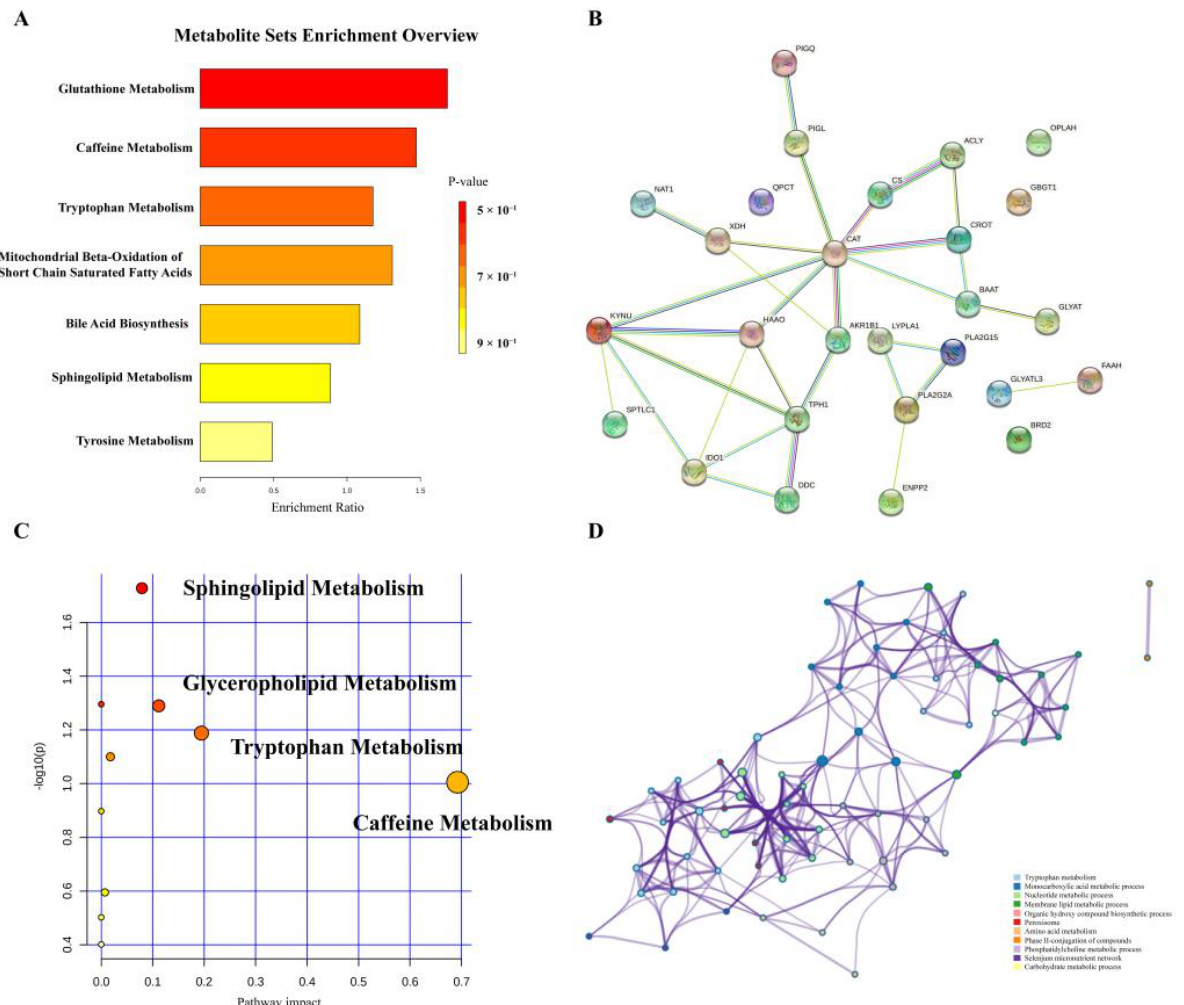
Figure 3. Enrichment analysis of metabolic pathways. ( A ) Overview of pathways related to the differential endogenous metabolites. ( B ) A summary of pathway analysis with Metascape. ( C ) Regulatory protein network map. ( D ) Regulatory enzyme GO enrichment analysis results.